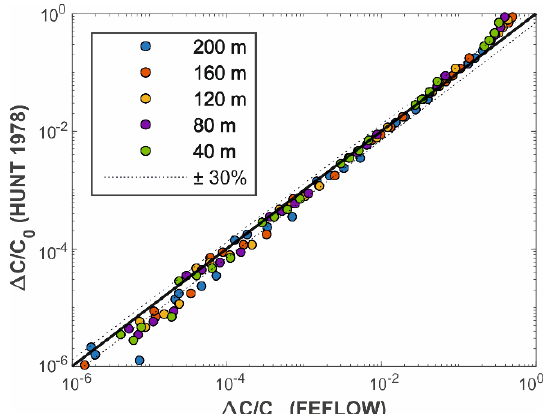
Figure 7. Comparison of the differential contamination ( Δ𝐶/𝐶 0 ) at the top of the deep aquifer and at different distances (40, 80, 120, 160 and 200 m) downstream the borehole outlet, resulting from FEFLOW numerical models (abscissa) and from Hunt’s solution of Equation 4 (ordinate).